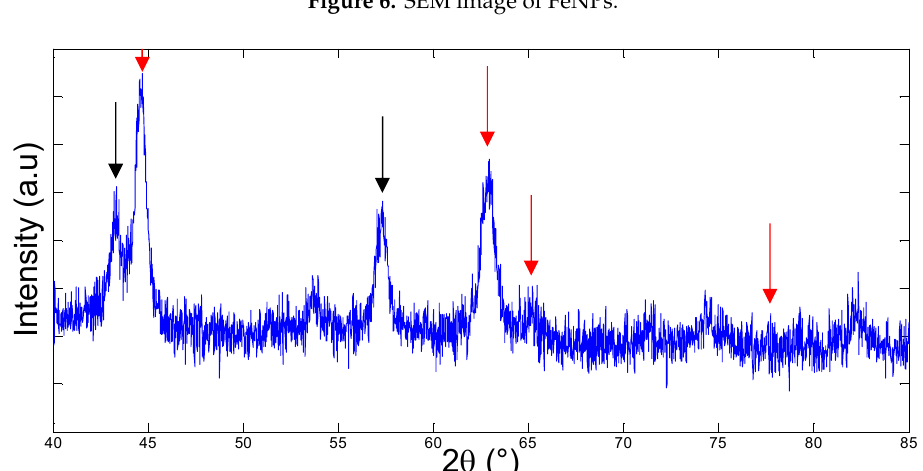
Figure 6. SEM image of FeNPs.